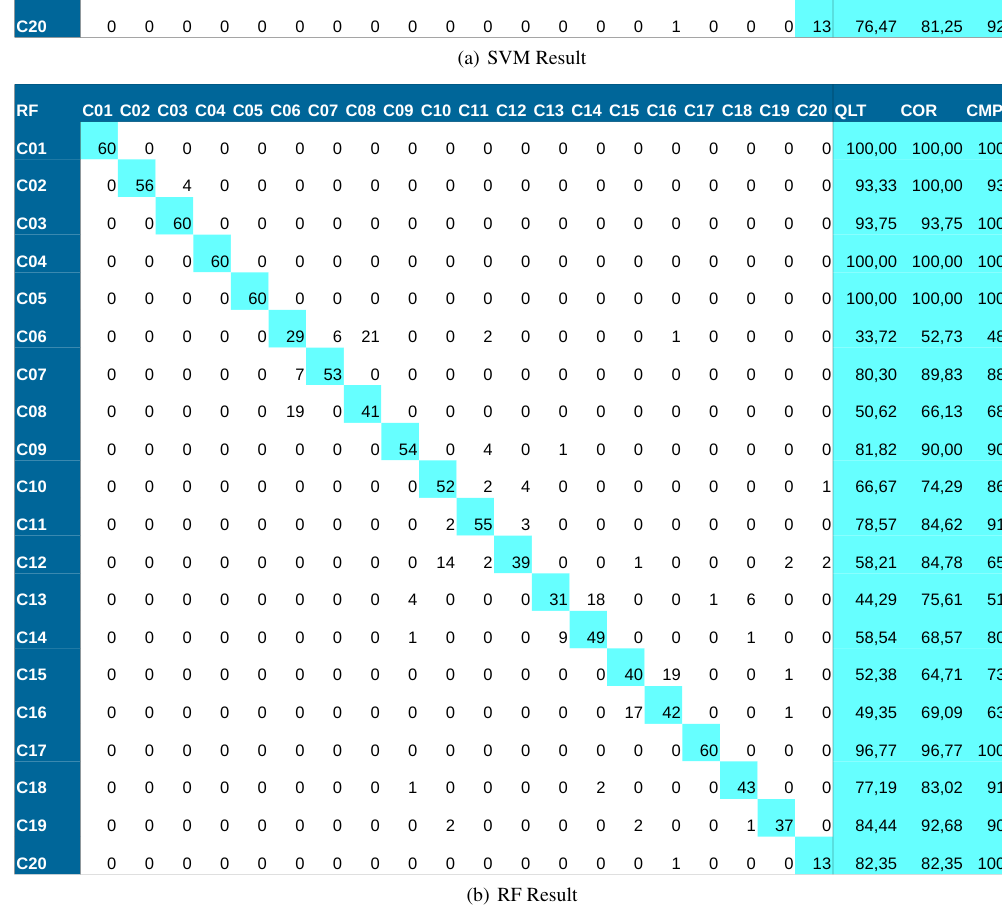
Figure 5. Confusion matrices of the Support Vector Machine (above) and Random Forest (below) result. Rows: known classes, Columns: predicted classes. Overall accuracy and class-specific quality measures included. Larger image available at: www.ipf.kit.edu/code.php